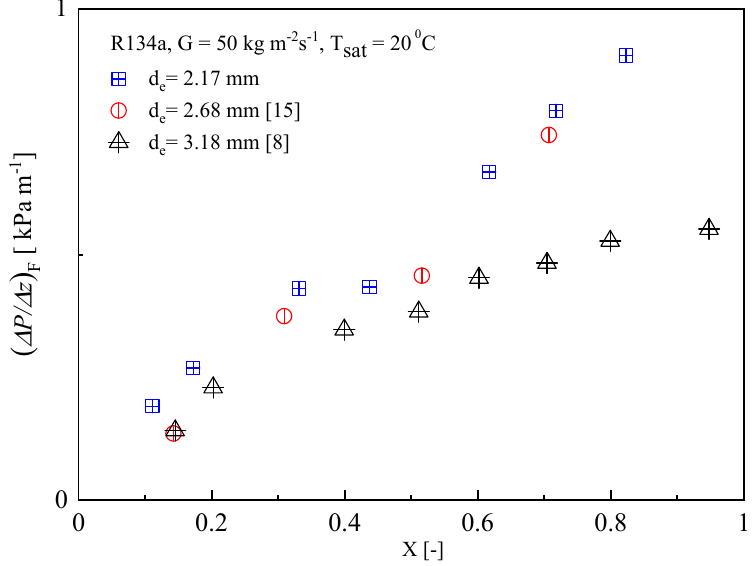
Figure 7. Effect of tube diameter on frictional pressure drop.